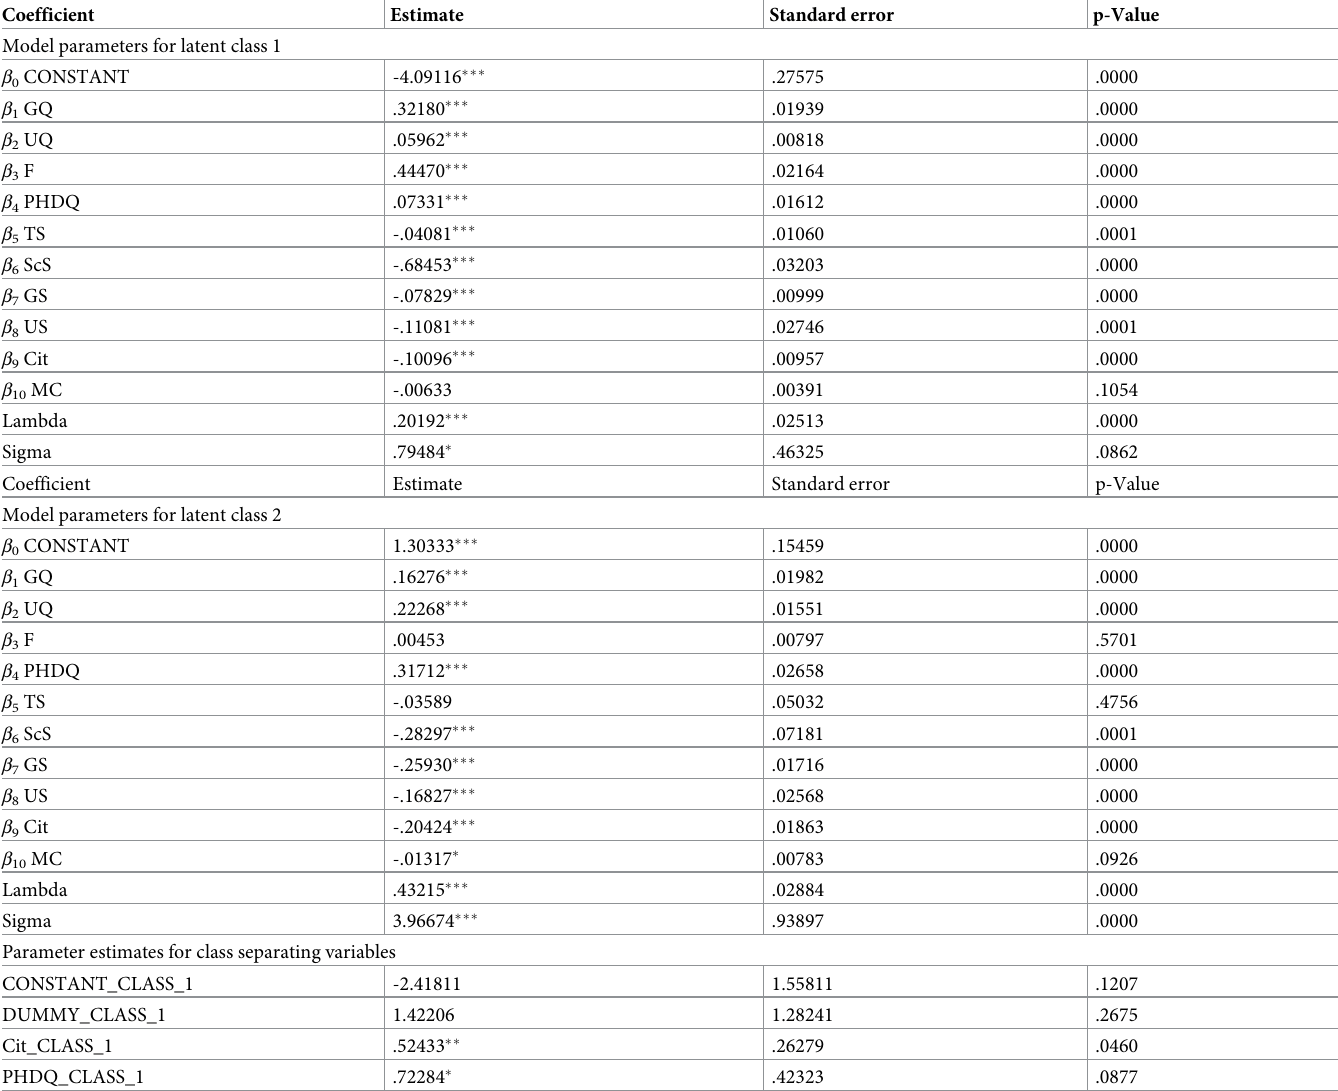
Table 7. Estimation results for the stochastic frontier latent class case.